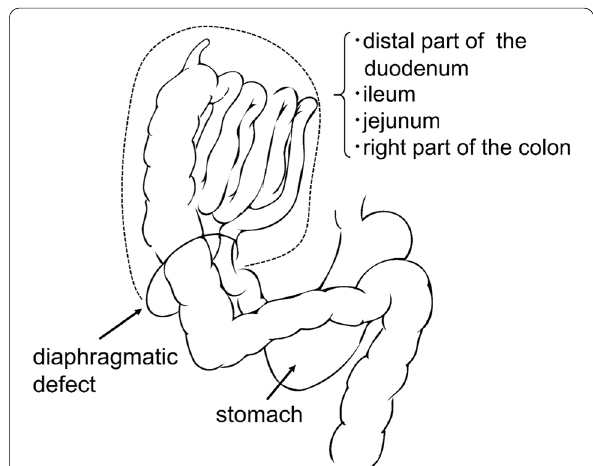
Fig. 4 Schematic illustration of the herniated digestive tract and intestinal malrotation. The distal part of the duodenum, ileum, jejunum, and the right part of the colon were herniated into the right thoracic cavity. The duodenum, cecum, and the ascending colon had lost the fixation to the